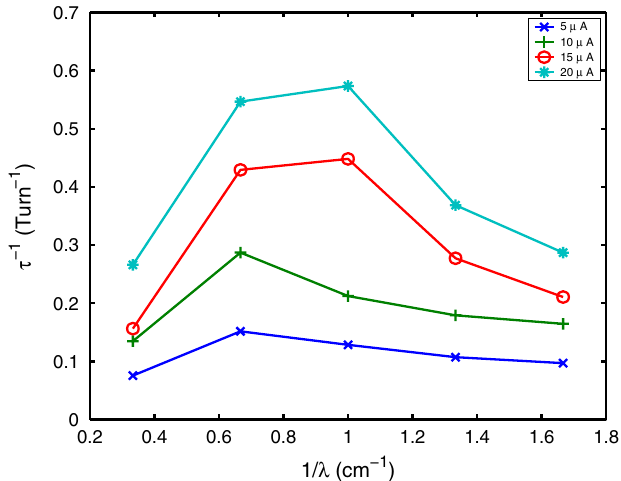
FIG. 10. (Color) Amplitude growth rate of harmonics (cid:9) ¼ 0 : 6 , 0.75, 1, 1.5, and 3 cm. The growth rate shown for four different peak intensities: 5, 10, 15, and 20 (cid:3) A .